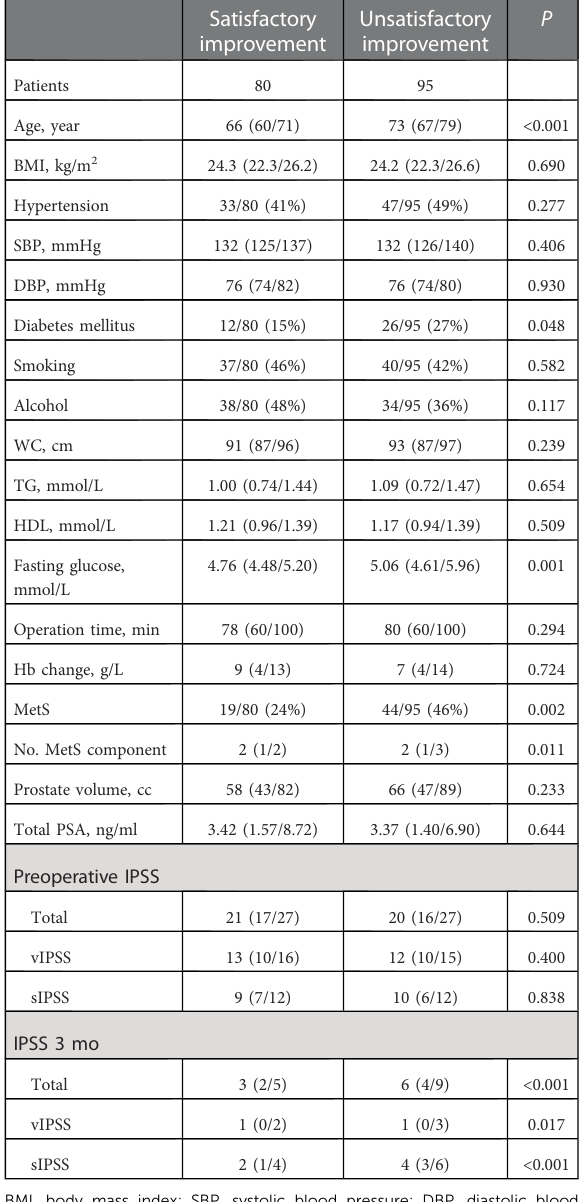
TABLE 2 Patient ’ s characteristics according to the improvement or not in nocturia after HoLEP.